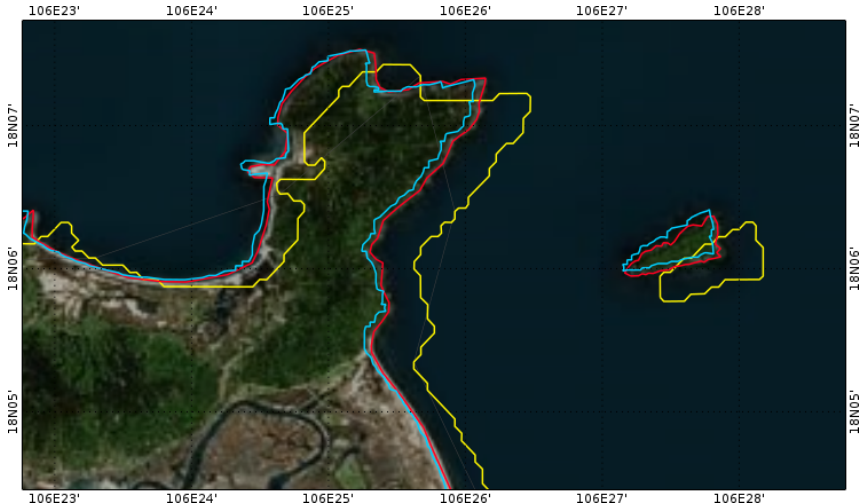
Figure 3. Shoreline products from OpenStreetMap (blue line), GSHHG (yellow line), and TONKIN_shorelines (red line) superimposed on a satellite image downloaded from Bing (© Bing™) over a small region of the